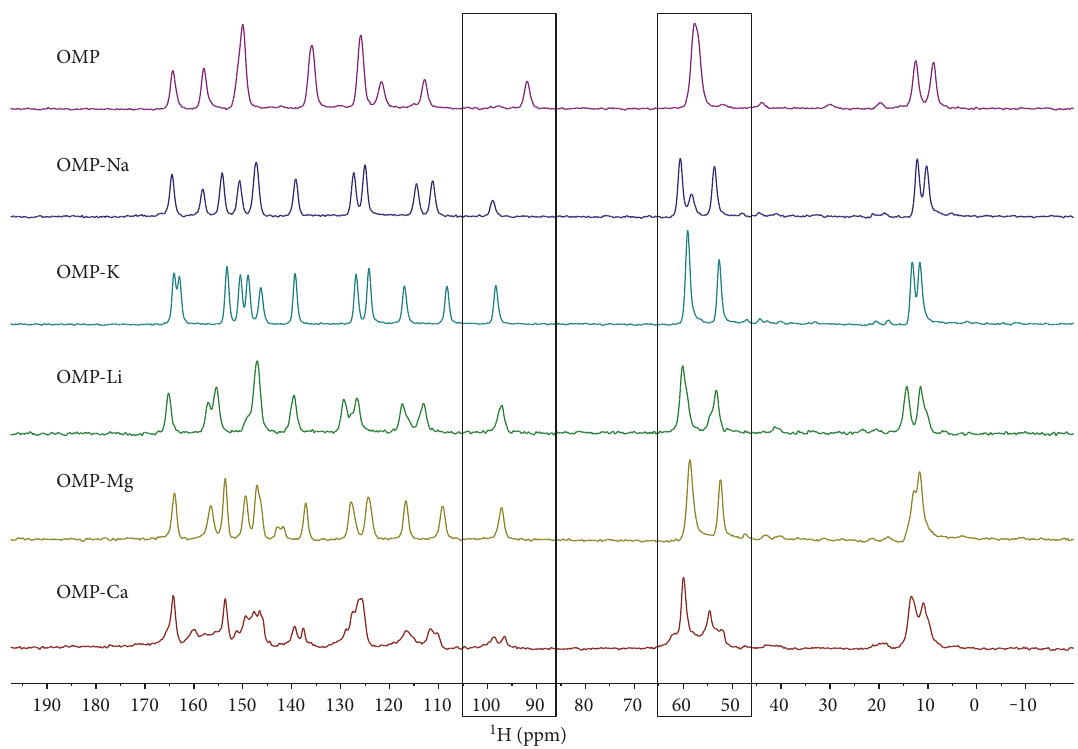
Figure 6: Comparison of 13 C CP-MAS NMR spectra of solid samples of OMP and OMP